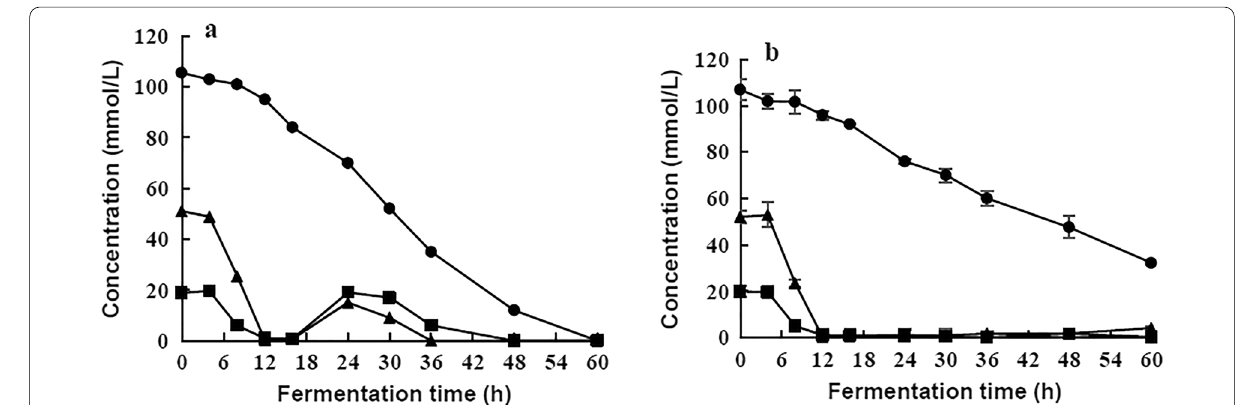
Fig. 6 Effect of pH control ( a ) and non-pH control ( b ) on carbohydrate utilization. Carbohydrates tested: